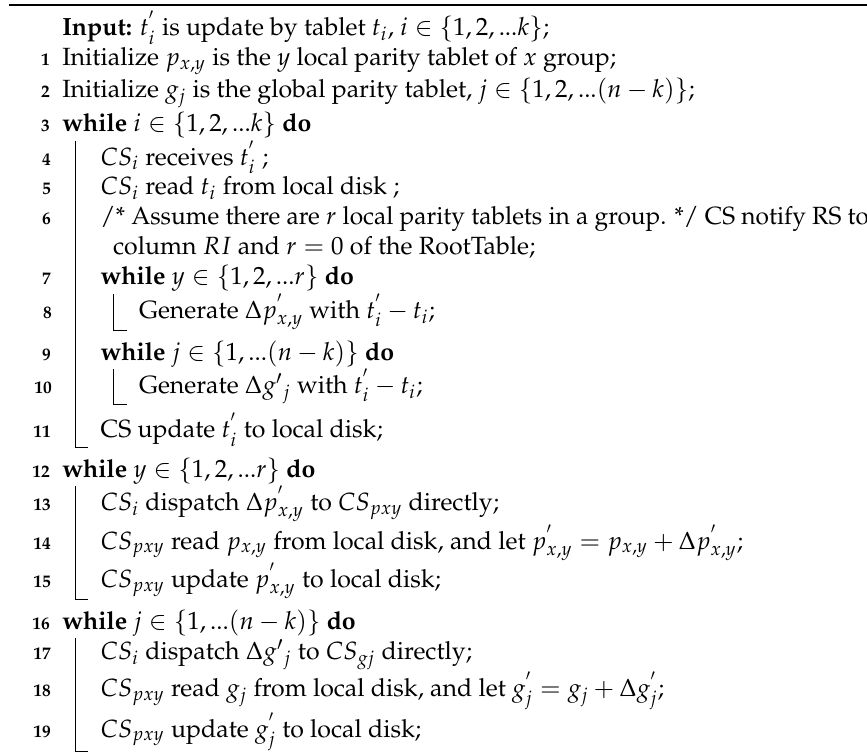
Algorithm 3: LRC increment update